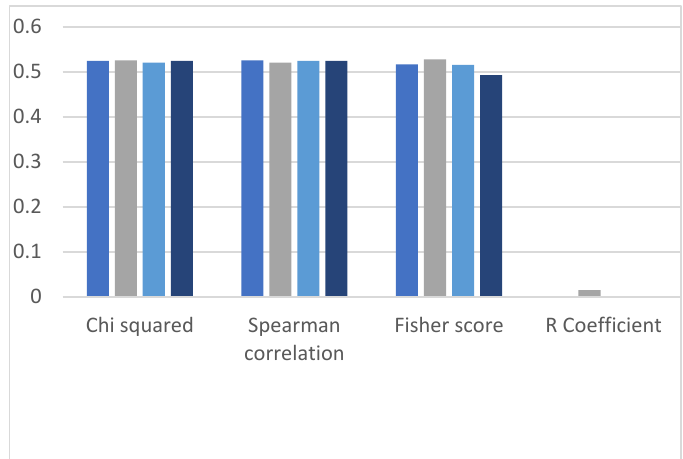
Figure 10. Precision using enhanced NN.